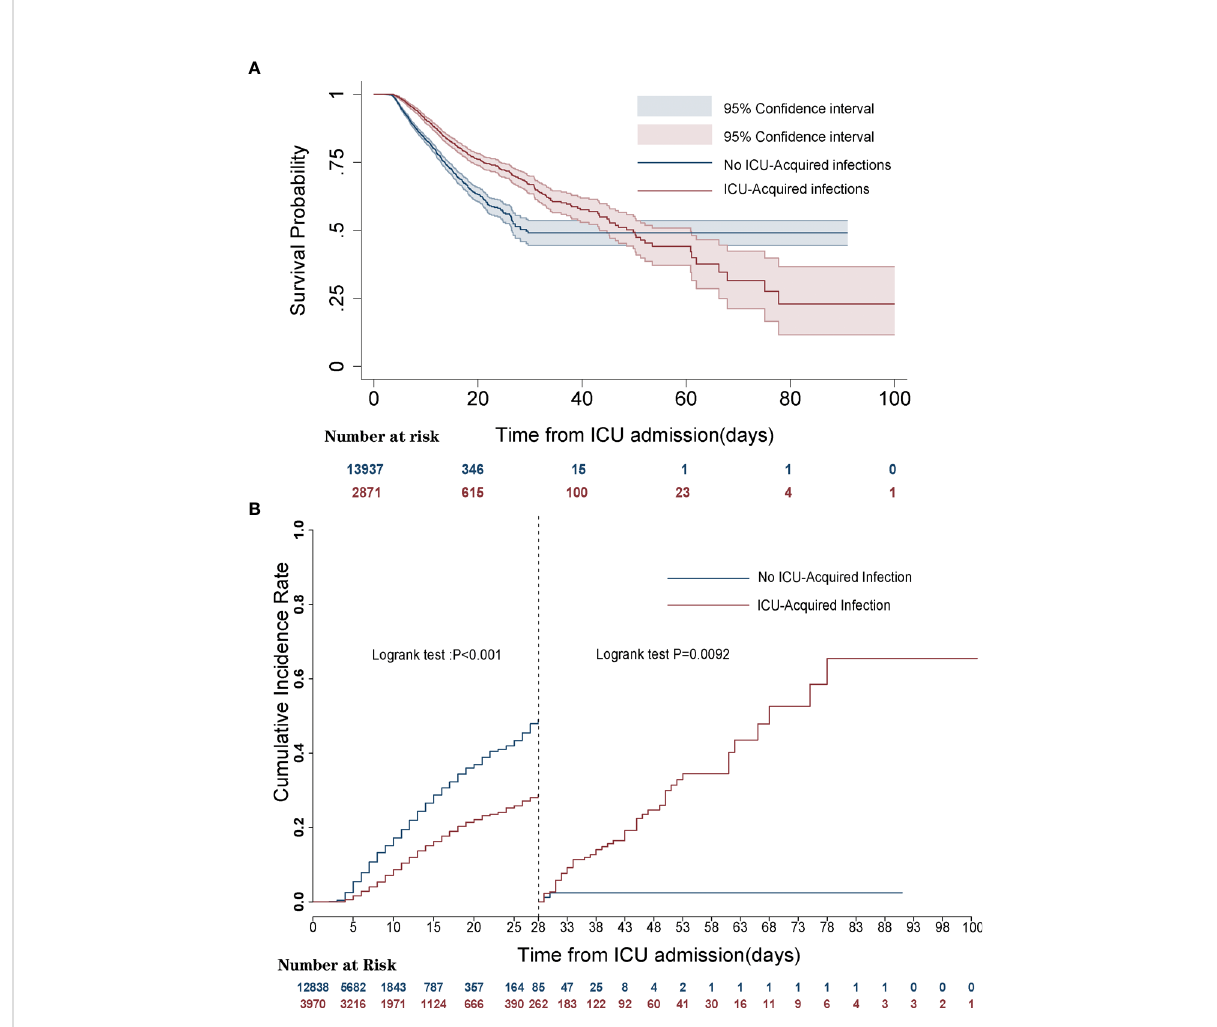
FIGURE 2 Survival curves of septic patients with and without intensive care unit (ICU)-acquired infections. (A) Kaplan – Meier survival curve. (B) Landmark analyses discriminating cumulative mortality comparing ICU-acquired infections with no ICU-acquired